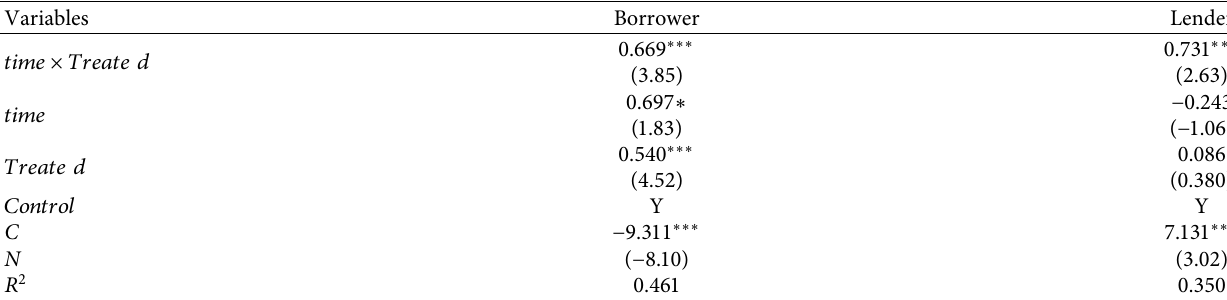
Table 12: The regression result of DID.